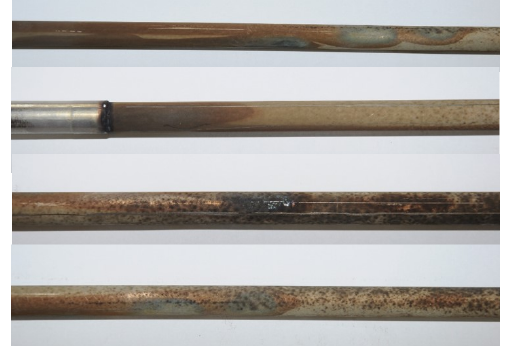
Figure 7. Detail of the test section with post glowing spots